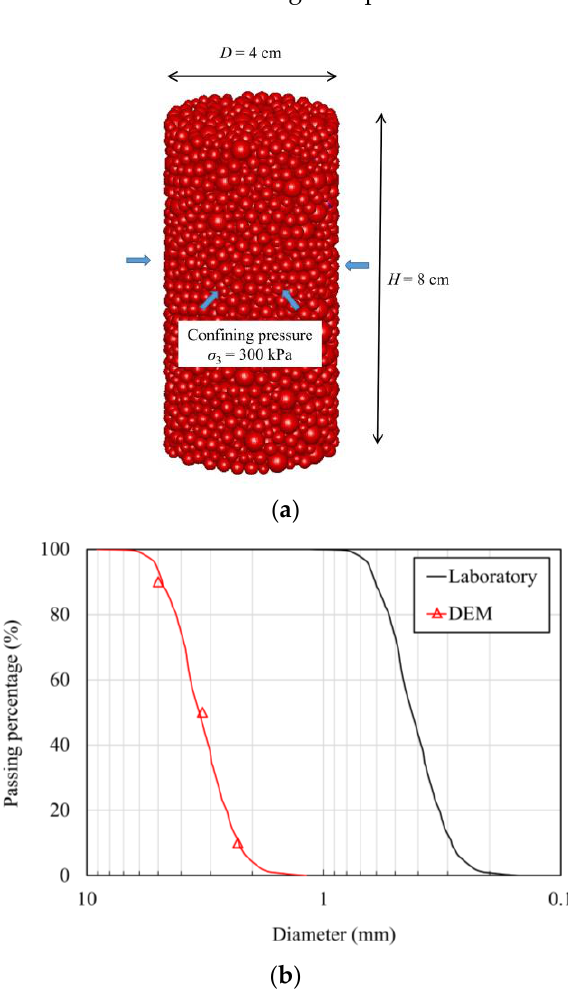
Figure 4. Schematic for discrete element model of the triaxial test. ( a ) specimen setup ( b ) particle size distribution.